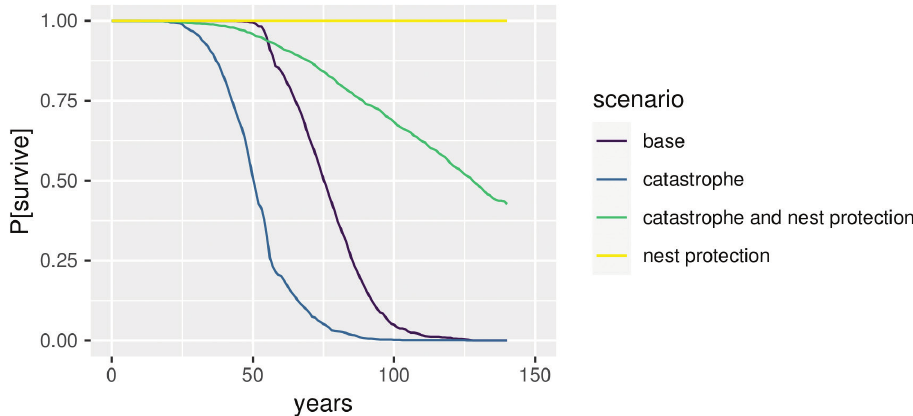
Figure 6. Probabilities of survival rate with displayed trajectories of the mean time of the first extinction in the simulated population viability